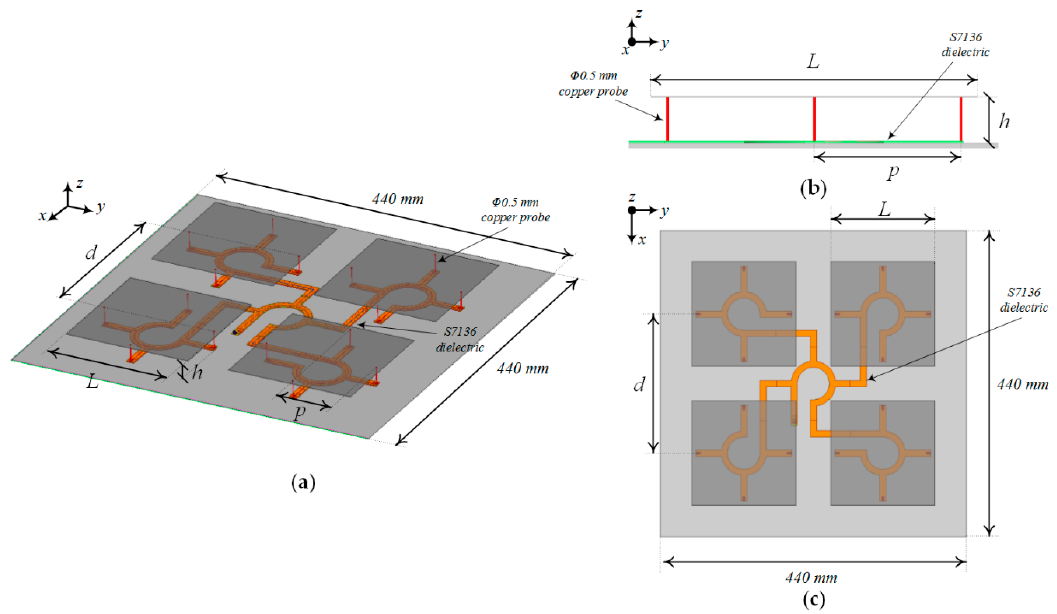
Figure 1. Antenna geometry: ( a ) three-dimensional view, ( b ) detail of lateral view for one antenna element, and ( c ) top view.